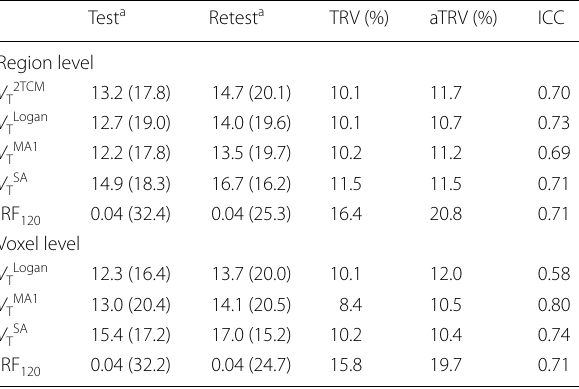
Table 3 Test–retest variability and reliability of different parameters of [ 18 F]LSN3316612 binding